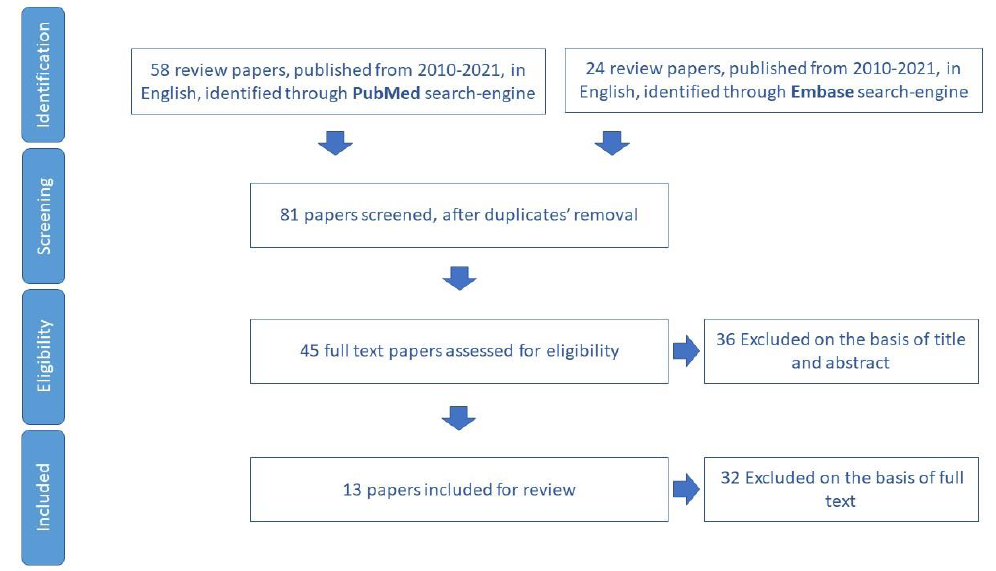
Figure 3. Process of study selection for nutrition domain.